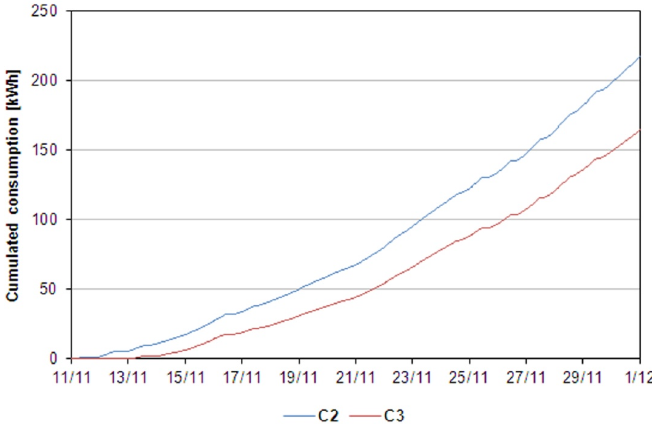
Figure 8. Energy consumption referring to the operation of the heat recovery unit alone, in winter.